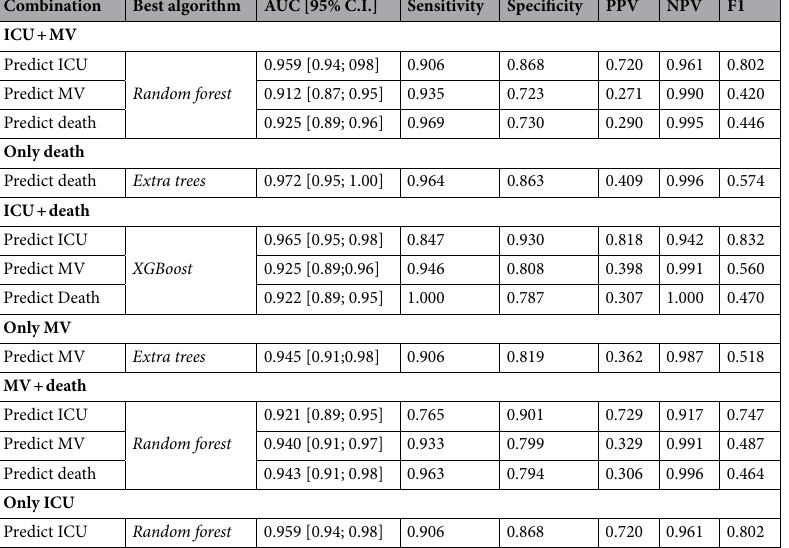
Table 2. Predictive performance comparison in the test set for aggregated and individual models, BP Hospital—A Beneficência Portuguesa de São Paulo, Brazil, 2020.